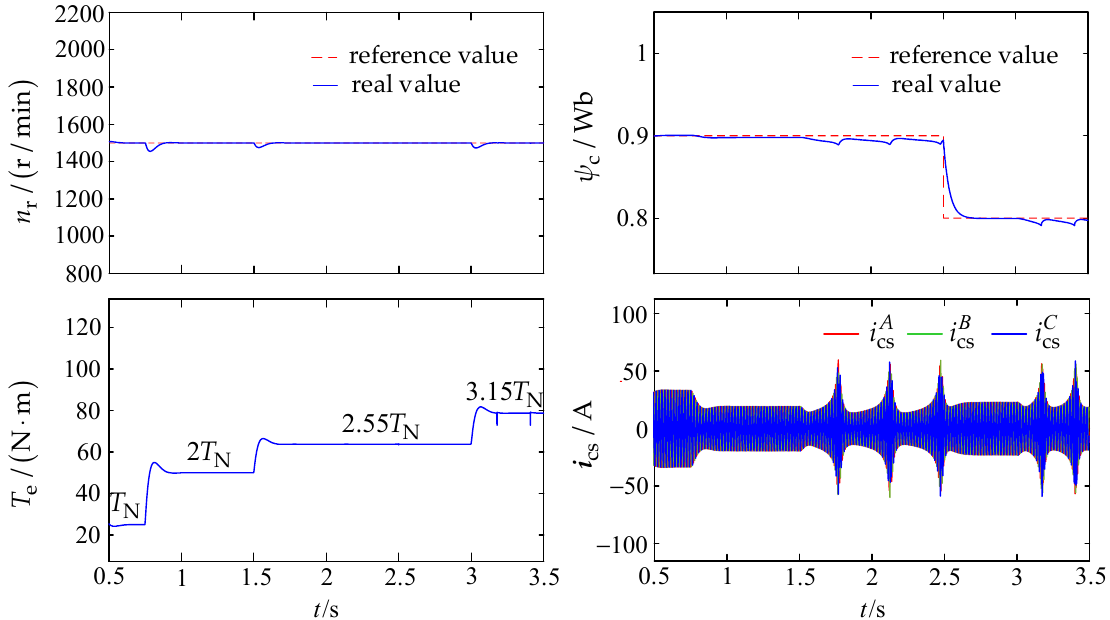
Figure 14. Simulation verification of the upper boundary of load torque.